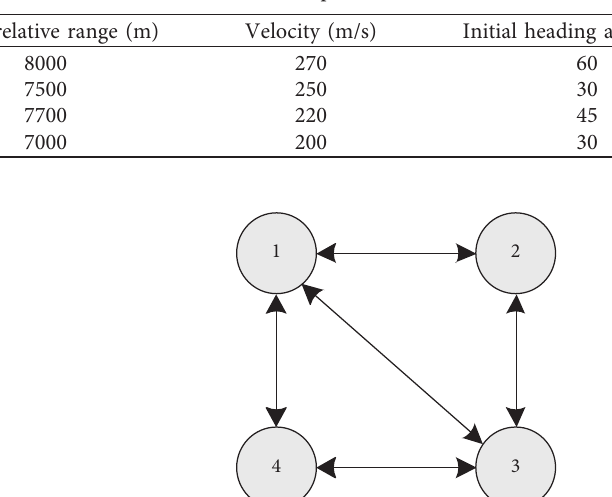
Table 1: Initial parameters for the four vehicles.